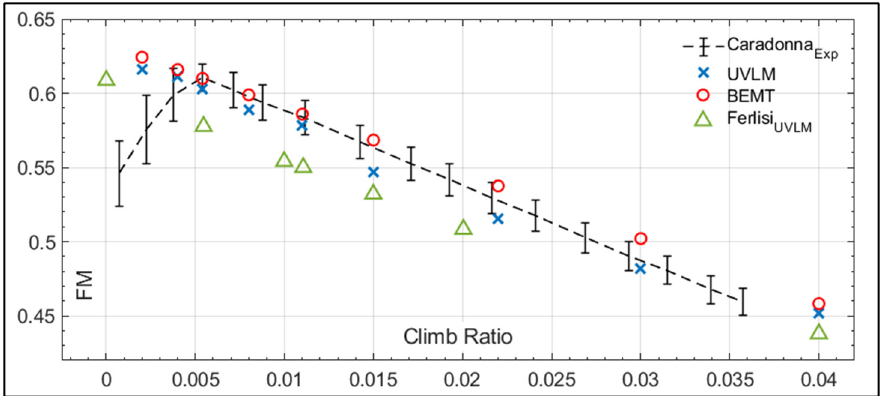
Figure 12. Figure of merit variation versus climb ratio.